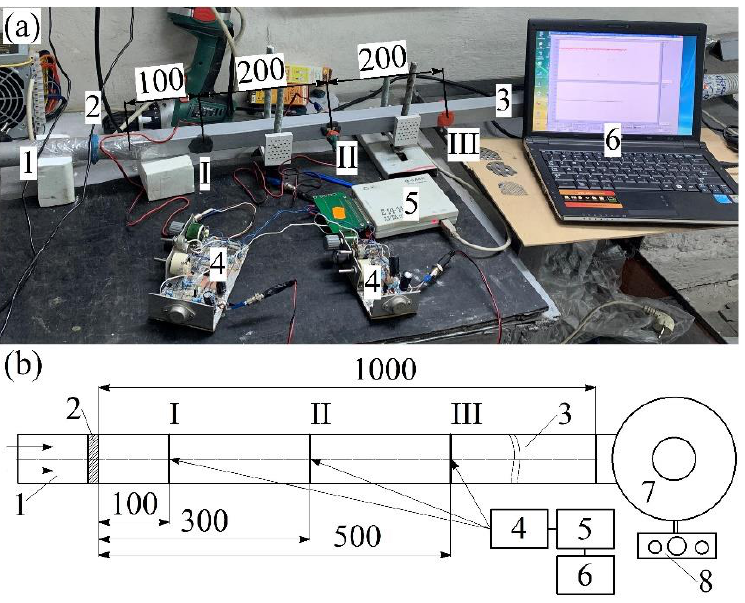
Figure 1. Photo ( a ) and scheme ( b ) of the test stand: 1 — entrance section; 2 — place of installation of the turbulator; 3 — investigated pipeline with different cross-sections; 4 — hot-wire anemometer of constant temperature; 5 — analogue-to-digital converter; 6 — laptop with software; 7 — pump; 8 — air flow control system; I, II, III — control section number.